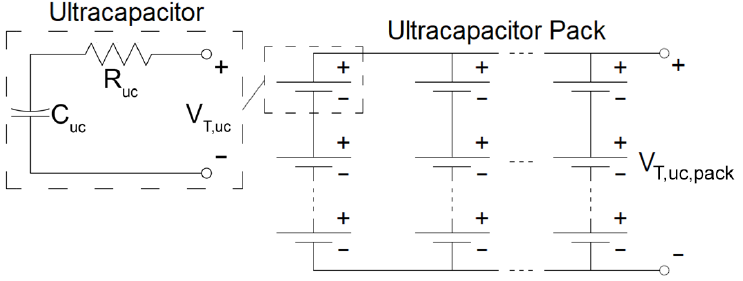
Figure 4. Ultracapacitor pack equivalent circuit. Table 3. Ultracapacitor model